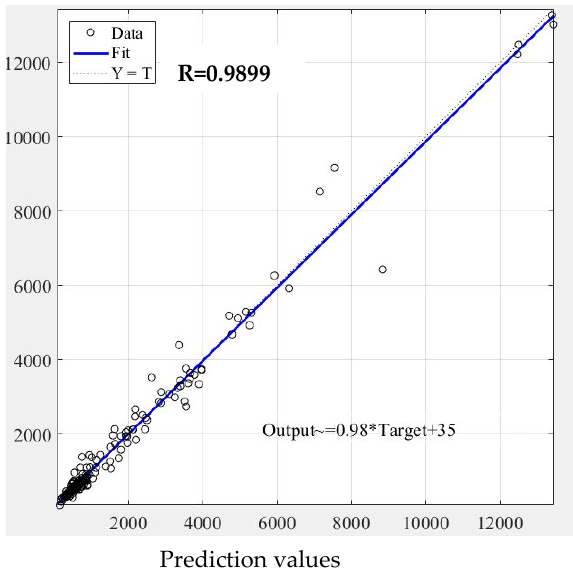
Figure 14. The regression plot of the predicted and target values of the total amount of concrete.